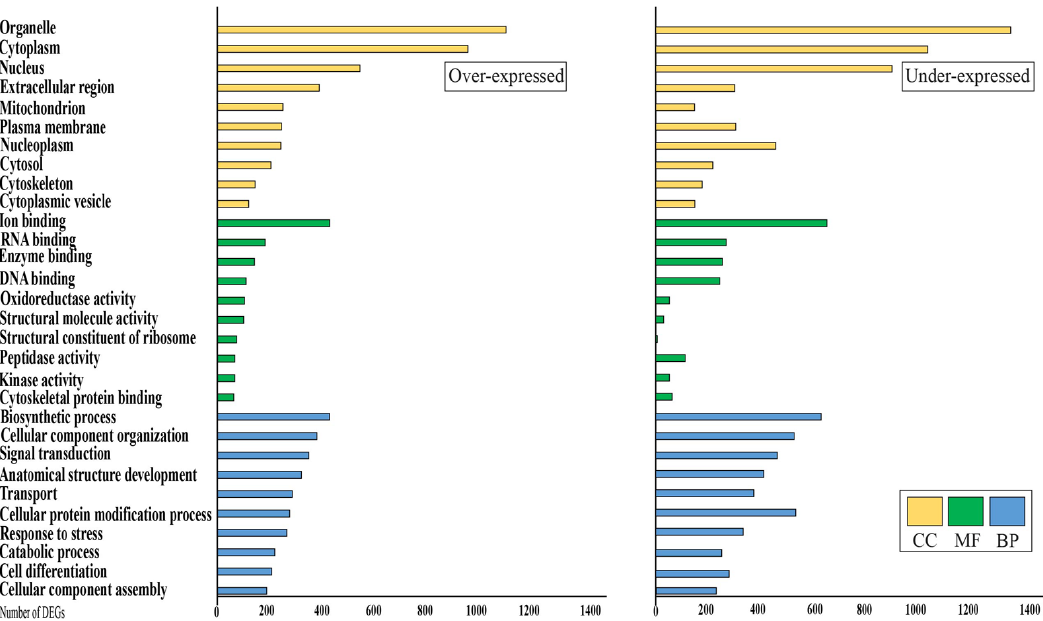
Figure 2. Distribution of gene ontology terms for over and under differentially expressed genes in sheep fed with linseed. Threshold was set to the top 10 most represented terms per major gene ontology classes. BP = biological process; MF = molecular function; CC = cellular component; DEGs = differentially expressed genes.